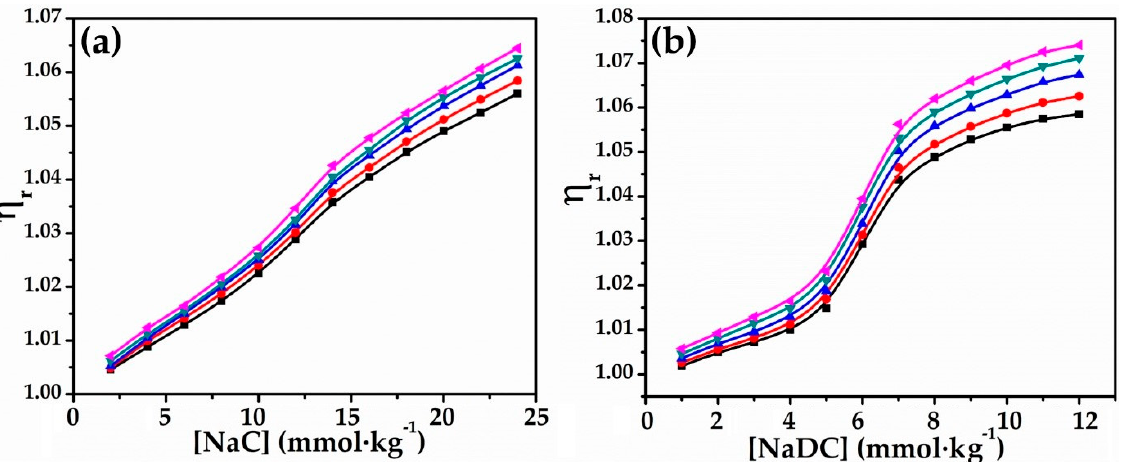
η Figure 4. Plots of r vs.( a ) [NaC] ( b ) [NaDC] in 0.010 mol ∙ kg − 1 aqueous solution of glycyl glcine at 293.15 K ( (cid:4) ), 298.15 K ( • ), 303.15 K ( (cid:78) ), 308.15 K ( (cid:72) ), and 313.15 K ( (cid:74) 293.15 K ( ■ ), 298.15 K ( ● ), 303.15 K ( ▲ ), 308.15 K ( ▼ ), and 313.15 K ( ◄ ).